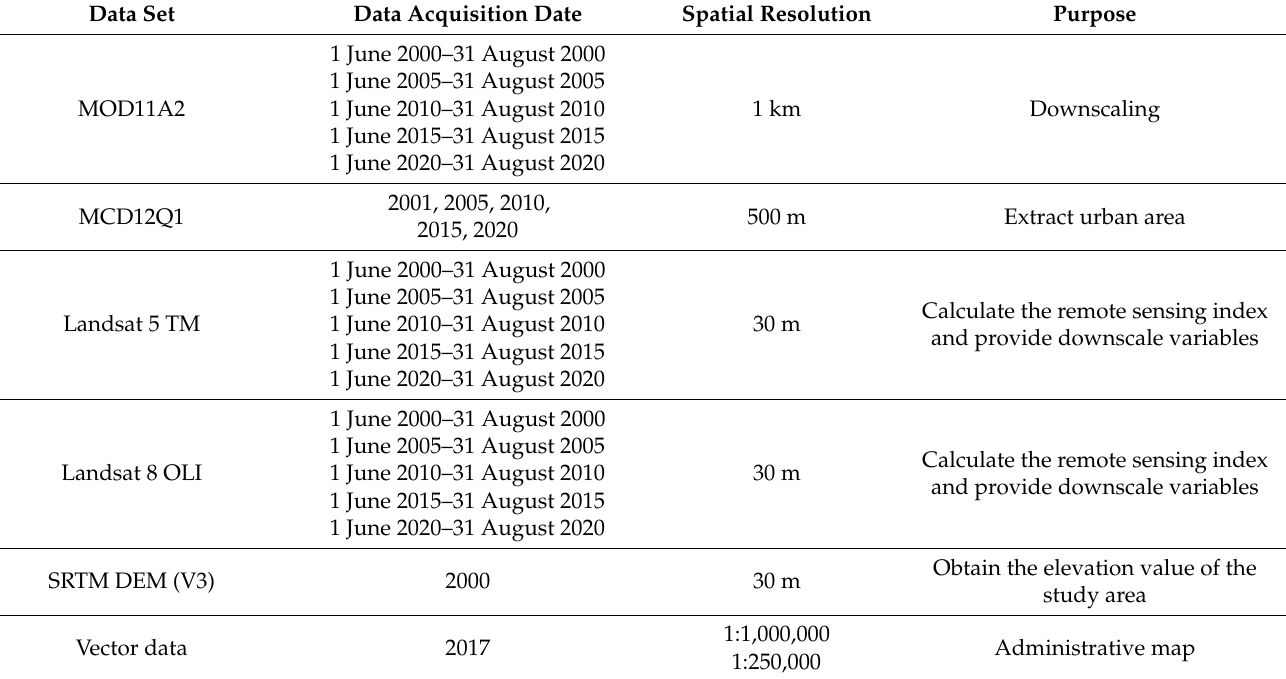
Table 1. Description of data used in this